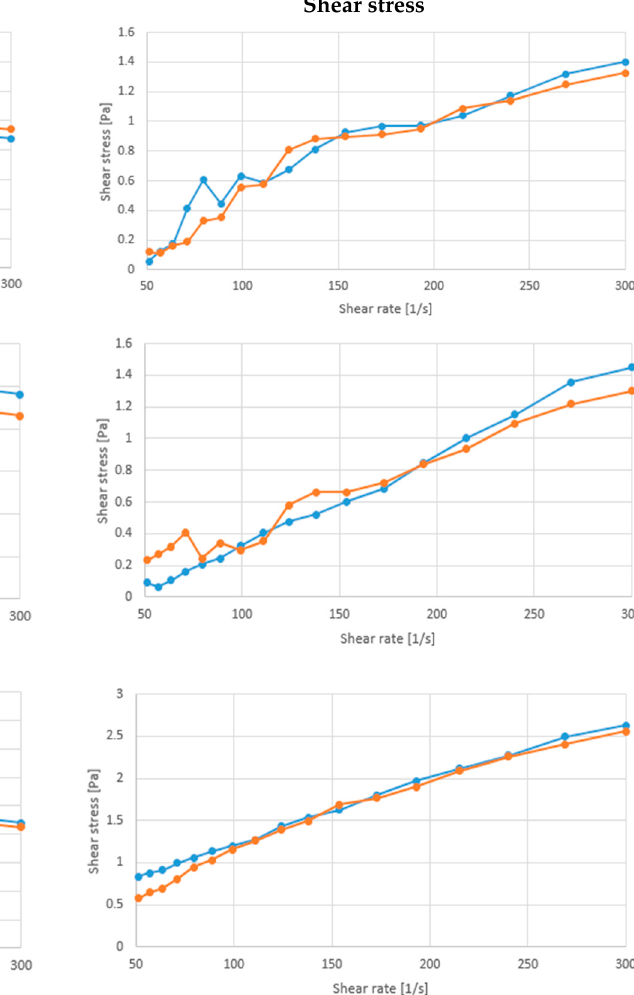
Figure 4. Relationship between viscosity/shear stress and increasing shear rate at 20 °C of the sample with ( a ) Soy drink + L. rhamnosus, ( b ) Soy drink + L. rhamnosus + Xylitol , ( c ) Soy drink + L. rhamnosus + C. vulgaris + Xylitol (experiments effectuated in duplicate red and blue line). As can be observed from the results, the soy drink fermented with both LAB in- creased the viscosity of the samples from 4.55 ± 0.15 mPa·s to 8.65 ± 0.15 mPa·s with L. fermentum and 6.6 ± 0.5 mPa·s with L. rhamnosus . In contrast, the addition of C. vulgaris reduced the viscosity through fermentation from 4.55 ± 0.25 mPa·s to 3.75 ± 0.05 mPa·s with L. fermentum and increased the viscosity to 8.85 ± 0.05 mPa·s with L. rhamnosus . The